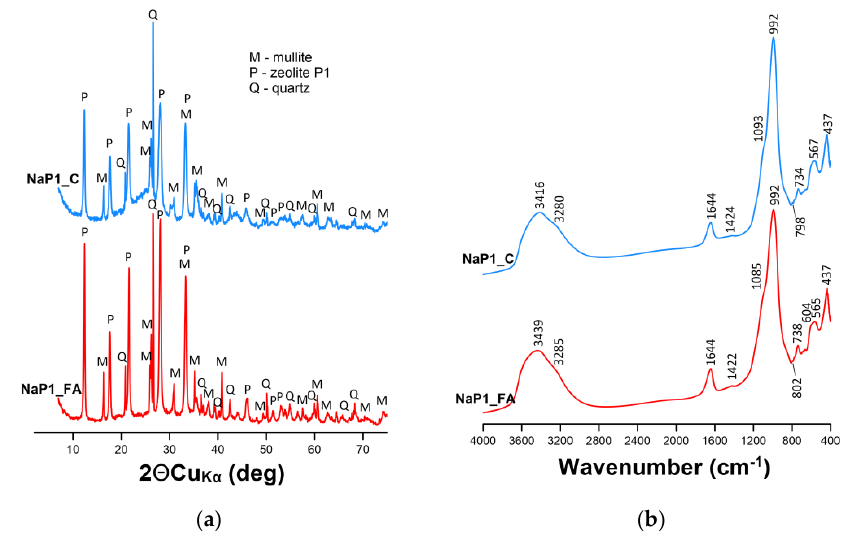
Figure 1. ( a ) X-ray diffraction patterns and ( b ) Fourier transform infrared spectra of NaP1_FA and NaP1_C samples.